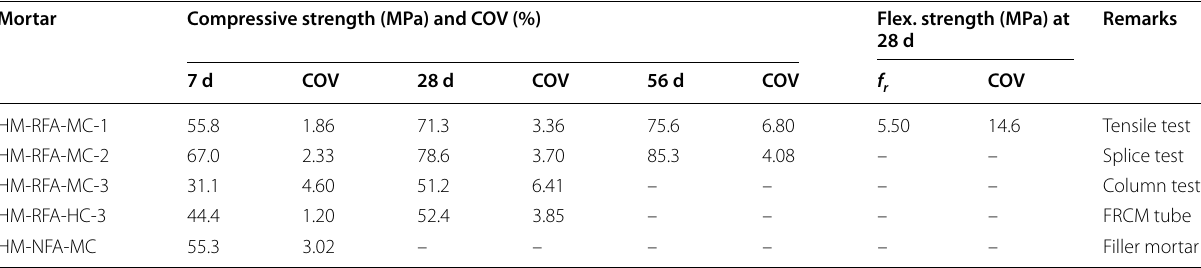
Table 3 Summary of mortar strength